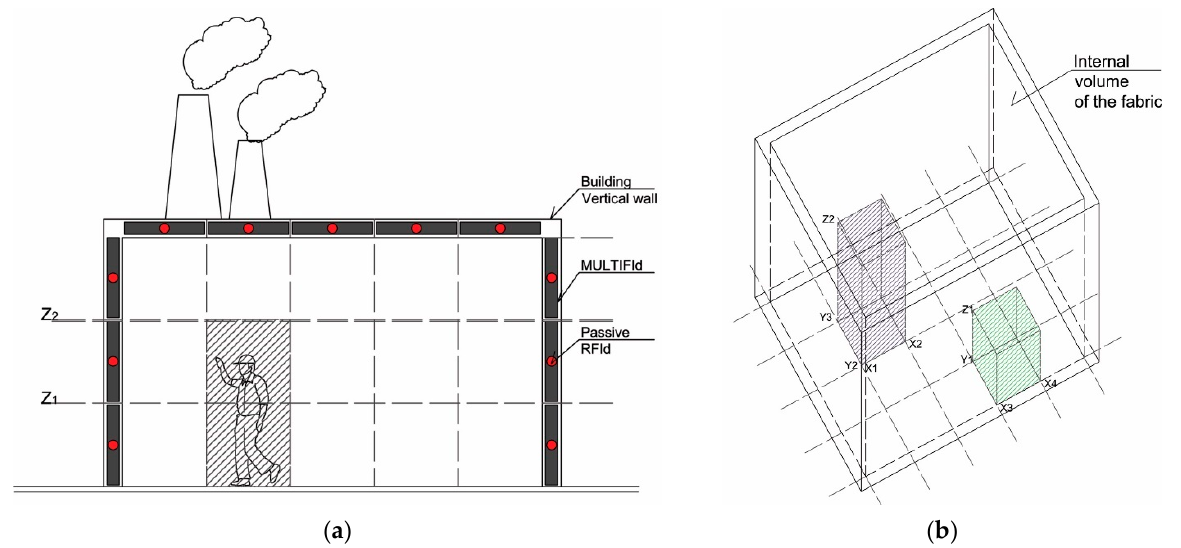
Figure 6. Sections of a typical work environment: ( a ) vertical section; ( b ) horizontal section.